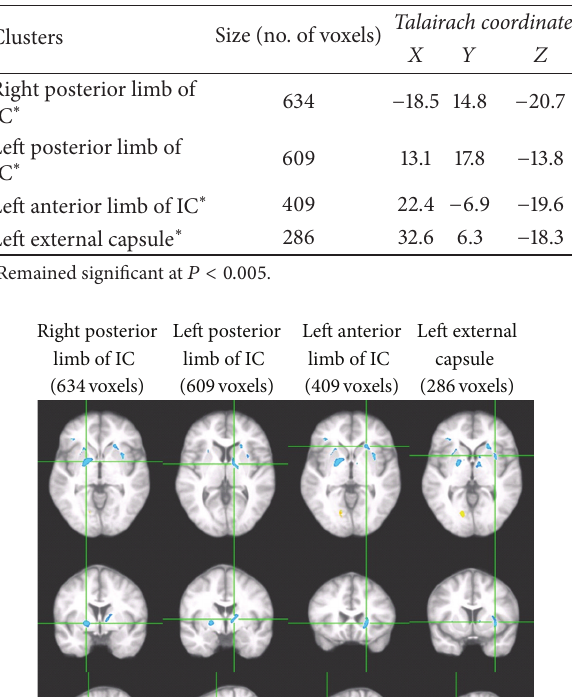
Table 2: Significant clusters demonstrating FA reduction among HTN relative to normotensive participants ( > 200 voxels in size; 𝑃 < 0.01 ).